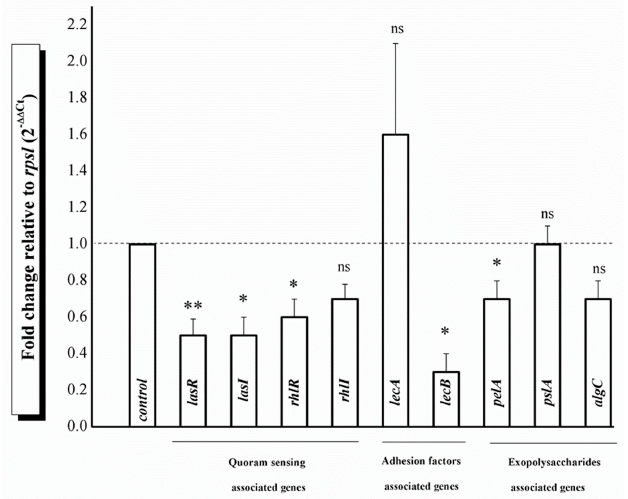
Figure 8. Effect of modified silicone surface on gene expression levels of biofilm-associated genes in